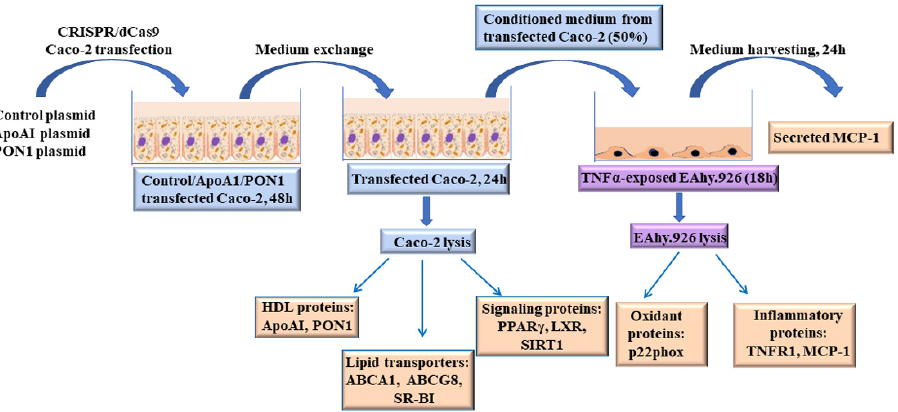
Figure 1. Graphical representation of the experimental design. Caco-2 cells were transfected with ApoAI or PON1 CRISPR activation plasmids. Then, 48 h after transfection, the medium was replaced and the cells were incubated for another 24 h with DMEM to obtain the conditioned media enriched in ApoAI or PONI. After this time interval, Caco-2 cells were lysed and further processed for Real-Time PCR and Western blot analysis. The conditioned media from transfected Caco-2 cells were used to evaluate their effects on EC function.